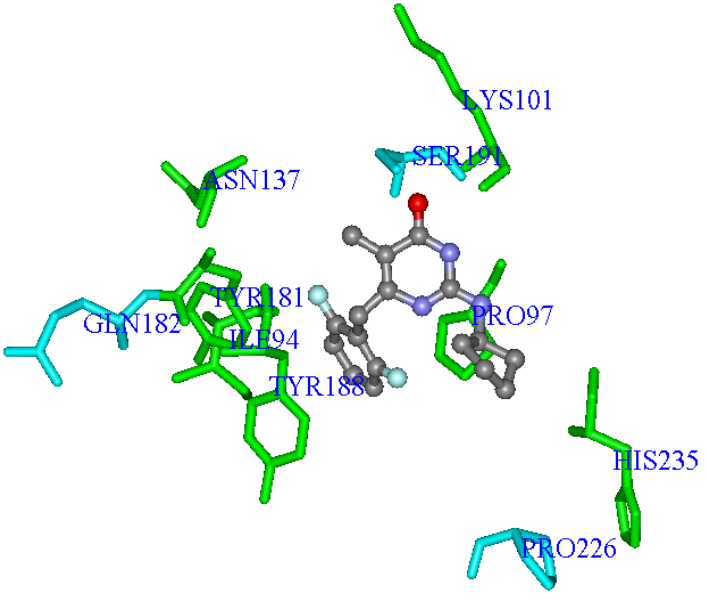
Figure 5. Three-dimensional graphic representation of Eq.E (Tables 3 and 4, DB-I ), using the most potent NH-DABO, compound 59 (stick-and-ball model colored by element), as example. The amino acids residues (stick model) colored in green ( Ile94 , Pro97 , Lys101 , Tyr181 , Tyr188 , His235 and Asn137 ) represent Lennard-Jones contributions and those colored in light blue ( Gln182 , Ser191 and Pro226 ) represent Coulomb contributions. The hydrogen atoms were omitted for better